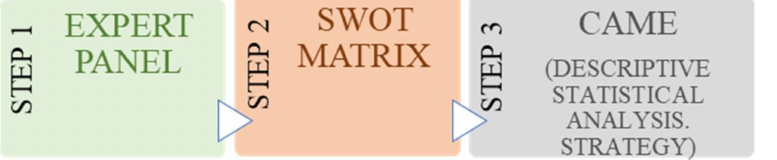
Figure 3. Methodological process. Source: Own elaboration.